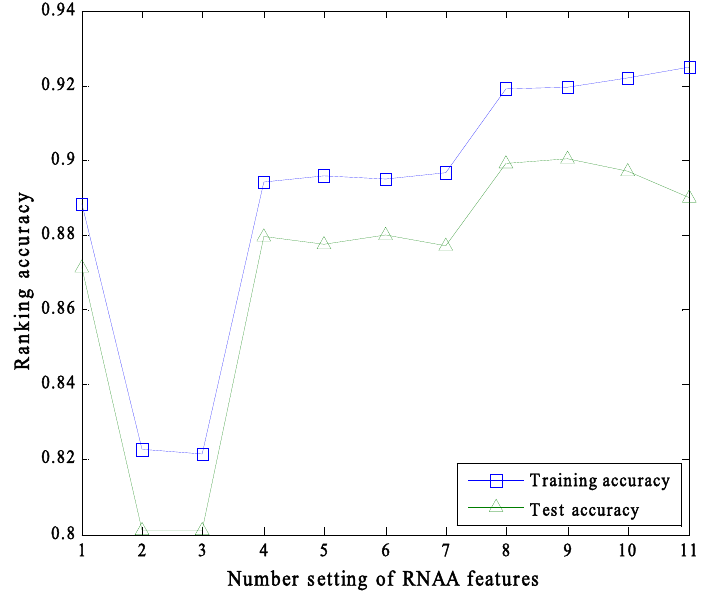
τ Figure 2. RAL ranking accuracy τ obtained on HyMap metric combinations learned with RNAA Figure 2. RAL ranking accuracy obtained on HyMap metric combinations learned with RNAA metrics shown in Table 2. metrics shown in Table 2.